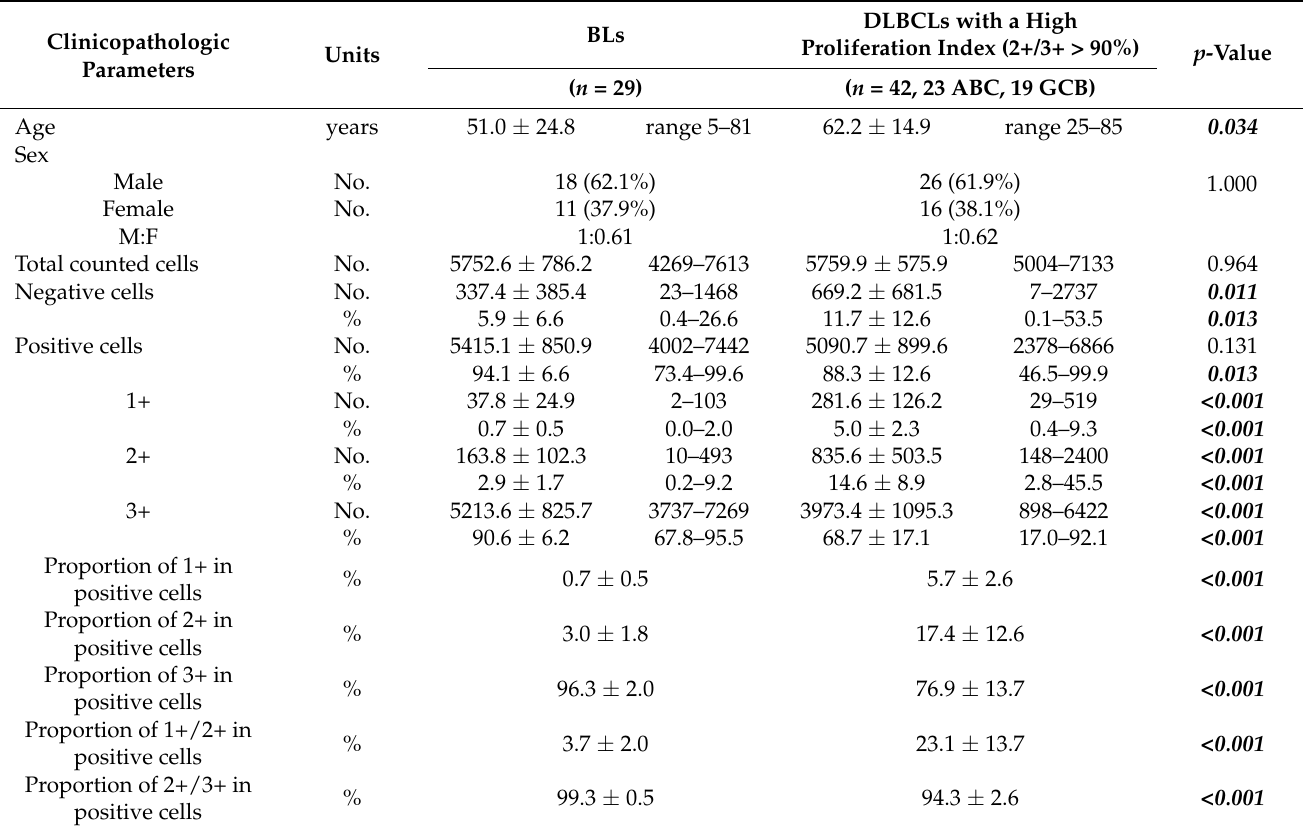
Table 3. Comparison of Ki-67 labeling index between Burkitt lymphomas (BLs) and diffuse large B-cell lymphomas (DLBCLs) with a high proliferation index (2+ and 3+ cells >90%). Significant p -values are bolded and